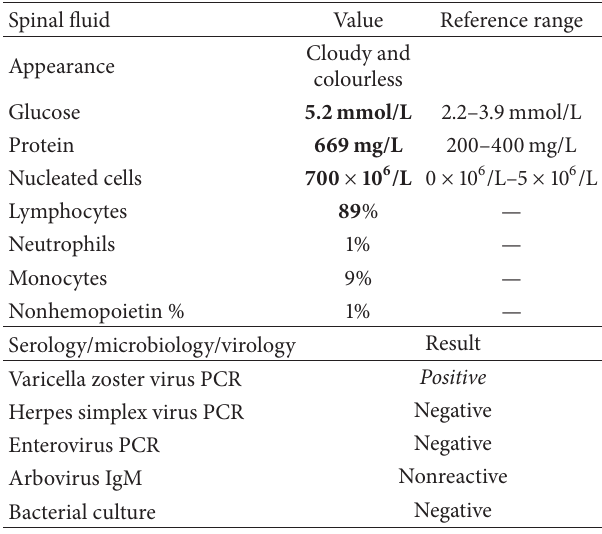
Table 1: Cerebrospinal fluid (CSF)